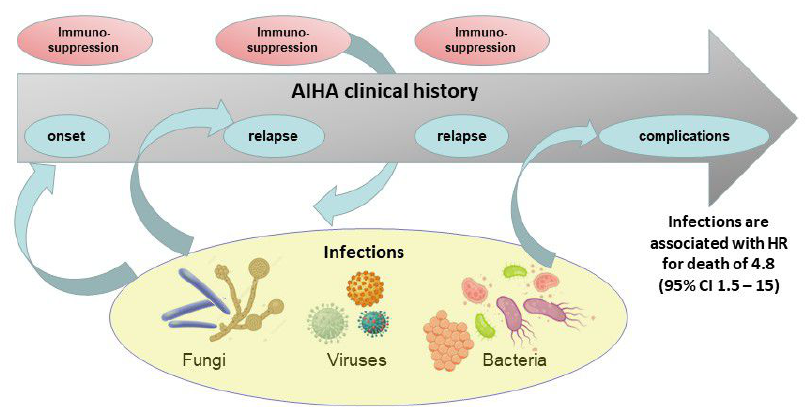
Figure 1. Relationships between autoimmune hemolytic anemia (AIHA) and infections during disease course. Infectious agents can be triggers for AIHA development at onset or at relapse (AIHA secondary to infections). On the other hand, immunosuppressive agents administered to treat AIHA expose the patient to infective events (infections secondary to AIHA), which are associated to disease complications and